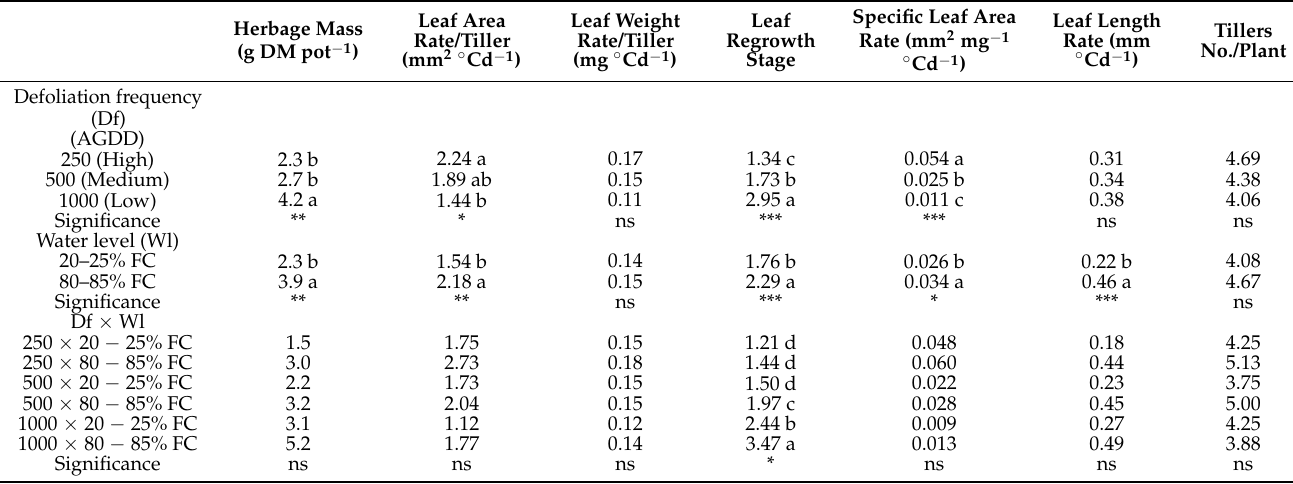
Letters that differ within columns indicate values that are significantly different at the following levels: * p ≤ 0.05; ** p ≤ 0.01; *** p ≤ 0.001; ns, not significant ( p >